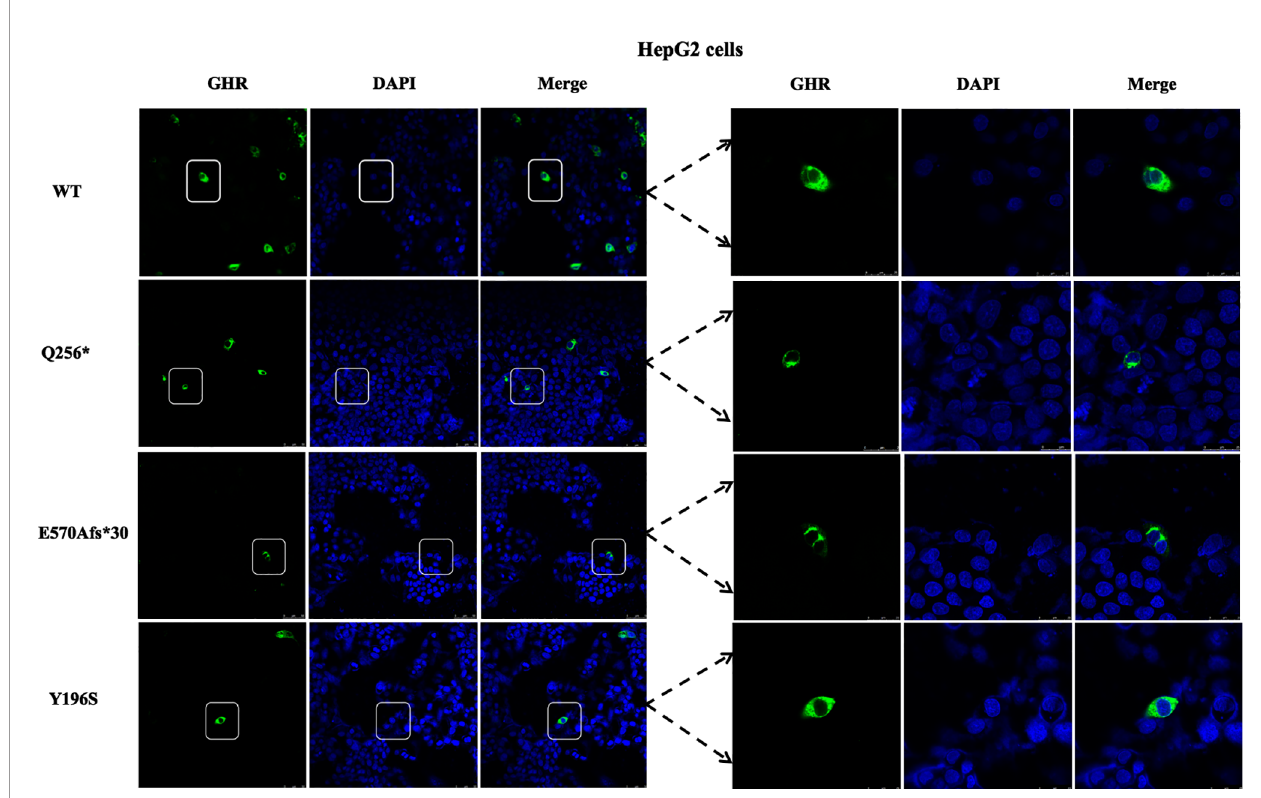
FIGURE 2 | Immuno fl uorescence images of HepG2 cells transfected with GHR wild type (WT) and mutant expression plasmids (Q256*, E570Afs*30 and Y196S). The GHR protein was labeled by anti-HA primary antibody in green, the nucleus was labeled by DAPI in blue, and the merged images were displayed in the right